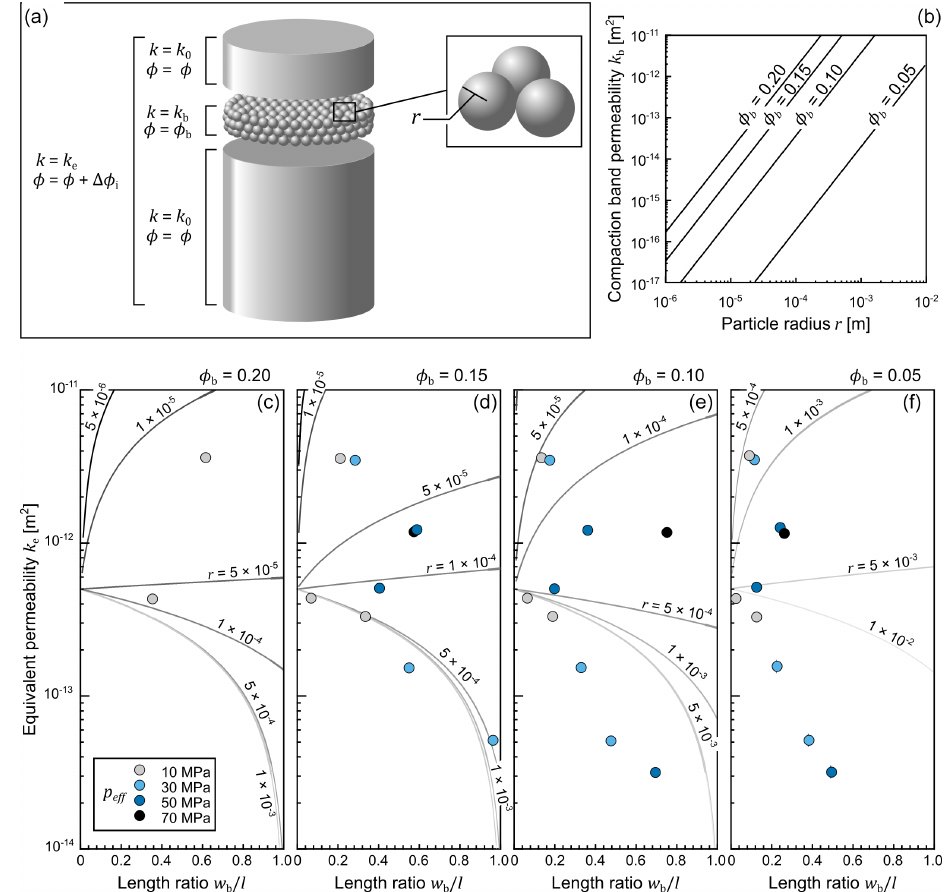
Figure 6. Model geometry and results. (a) Deformed sample may be thought of as a granular bed (with permeability k b and porosity φ b ) within a sample matrix, with permeability k 0 and porosity φ + (cid:49)φ i . Inset highlights the characteristic grain radius that governs surface area (Eq. 7). (b) The permeability of a compaction band composed of packed spheres as a function of sphere radius and bed porosity. Note that in reality, porosities < 0.26 would require a polydisperse packing of spheres or a granular bed composed of non-spherical grains. (c–f) Modelled equivalent permeability k e of a compaction band-bearing sample, plotted against the ratio of compaction band width relative to the overall sample length ( w b /l ), for compaction band porosities of φ b = 0 . 20 (c) , φ b = 0 . 15 (d) , φ b = 0 . 10 (e) , and φ b = 0 . 05 (f) . Also plotted are data from this study (Table 2), where values of w b are calculated after Eq. (4). Note that of the 10 k e ,w b /l data pairs from this study, not all are plotted on each of the panels (c) to (f) . This is because certain combinations of φ b and w b yield non-physical values (Eq. 4). Refer to text for further